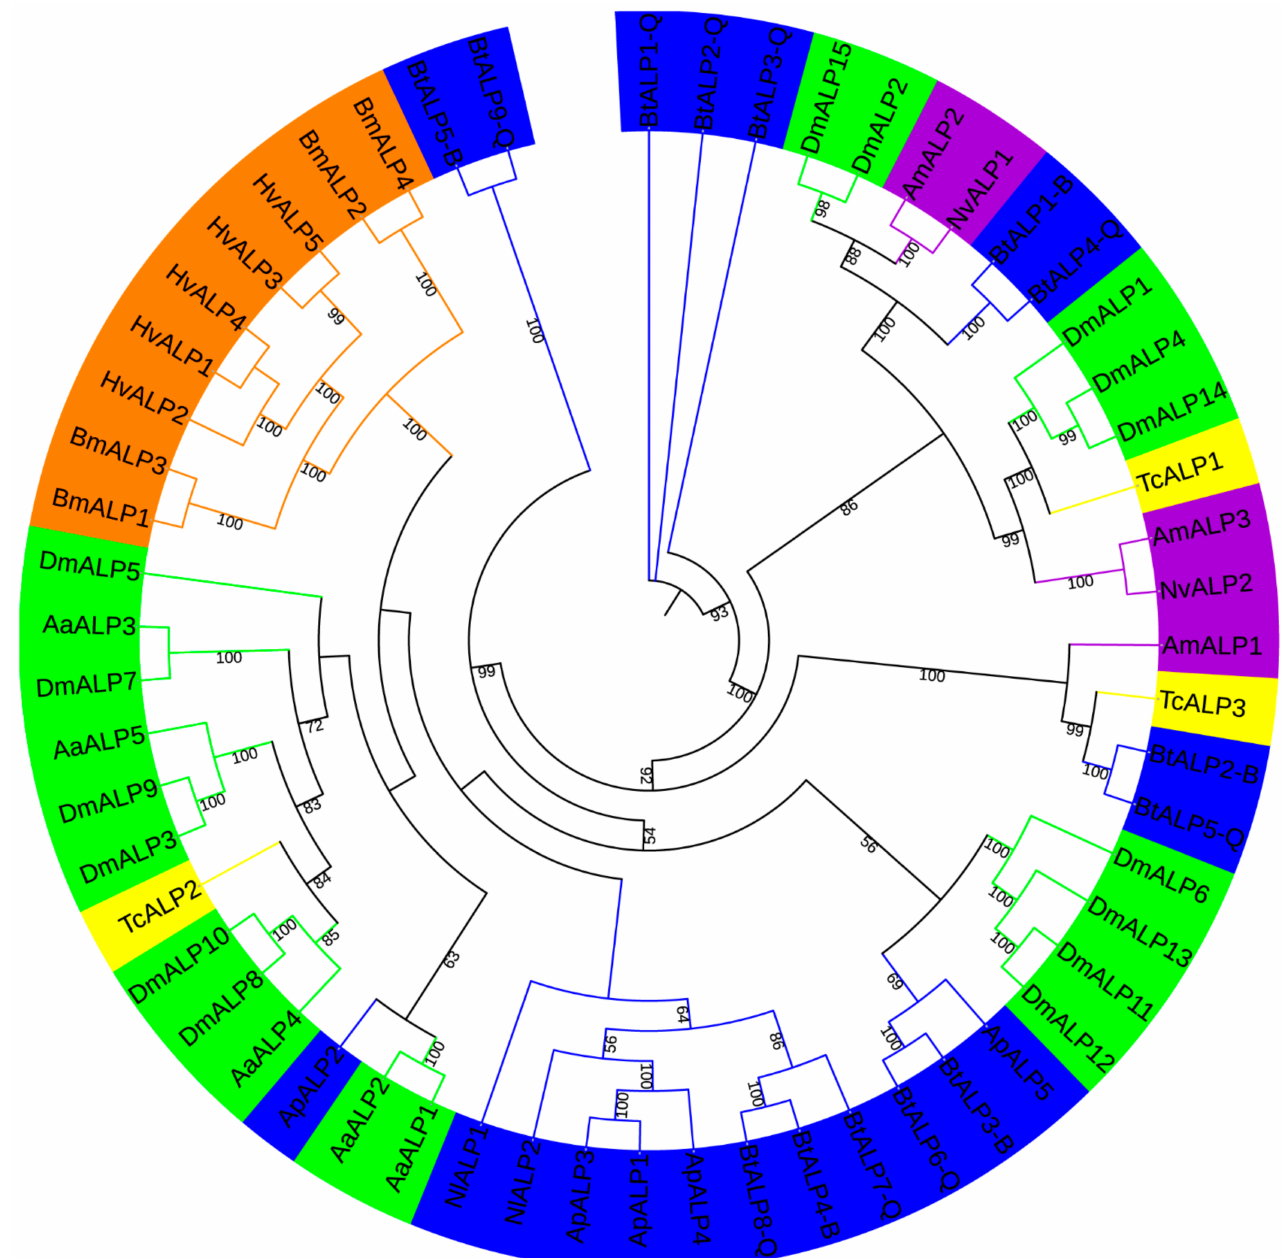
Figure 1. A maximum-likelihood phylogenetic tree generated by IQ-tree of ALP amino acid sequences from B. tabaci MEAM1 and MED and other insects. Bootstrap values are shown on each node, parameters used in generating this phylogenetic tree are shown in Methods. The insects from different orders are shown in different colors. The blue color represents Hemiptera (Nl, Nilaparvata lugens ; Ap, Acyrthosiphon pisum ; Bt, Bemisia tabaci MEAM1 and MED); the green color represents Diptera (Aa, Aedes aegypti ; Dm, Drosophila melanogaster ); the purple color represents Hymenoptera (Am, Apis mellifera ; Nv, Nasonia vitripennis ); the yellow color represents Coleoptera (Tc, Tribolium castaneum ); and the orange color represents Lepidoptera (Bm, Bombyx mori ; Hv, Heliothis virescens